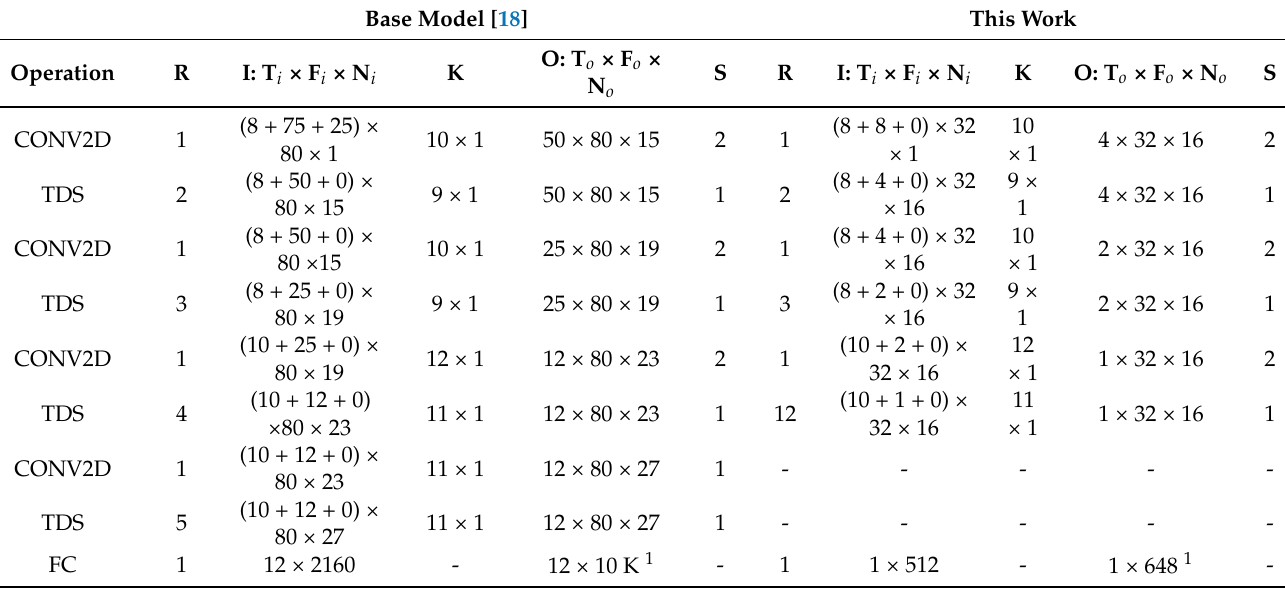
Table 3. Comparison of CNN model between the base model [18] and this work (R—#repetitions;